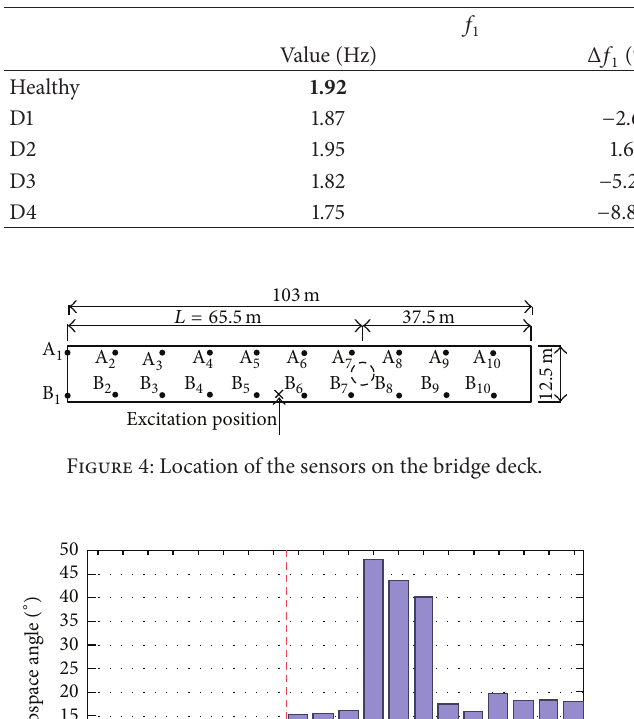
Table 2: Change in the eigenfrequencies (identified by SSI).